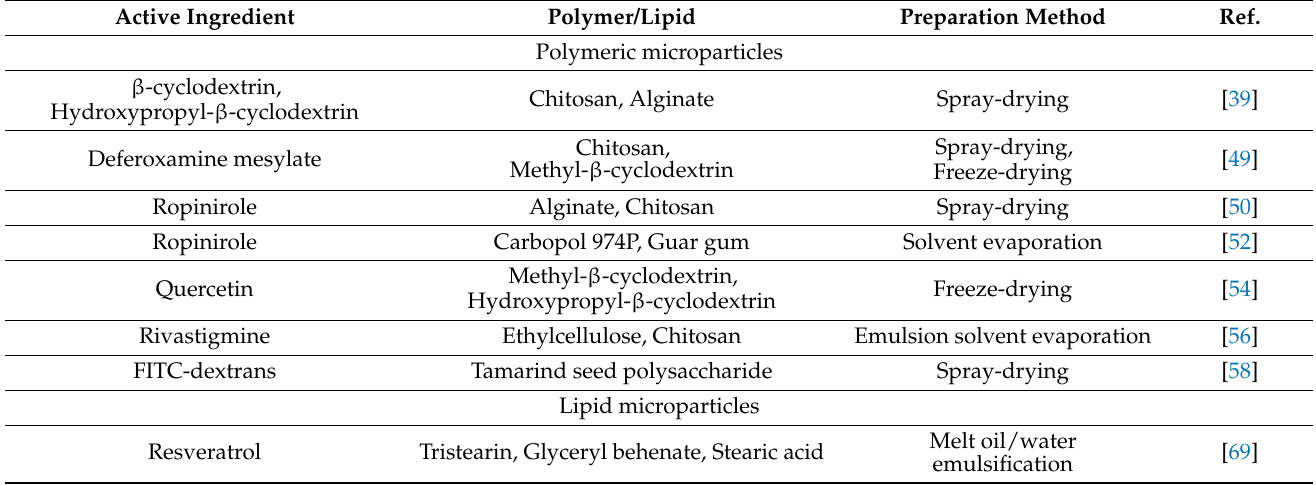
Table 1. Polymeric and lipid microparticles developed for nose-to-brain delivery in the treatment of